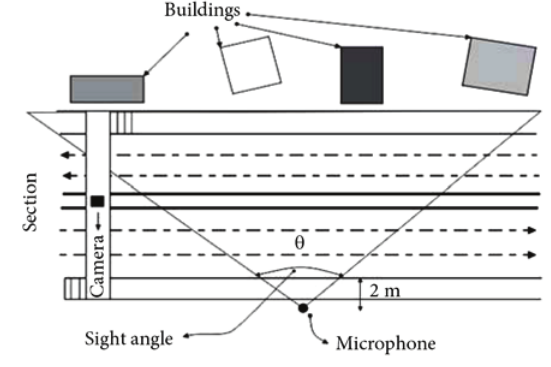
Figure 3. Distance of instruments to carriageway and angle of view from observer